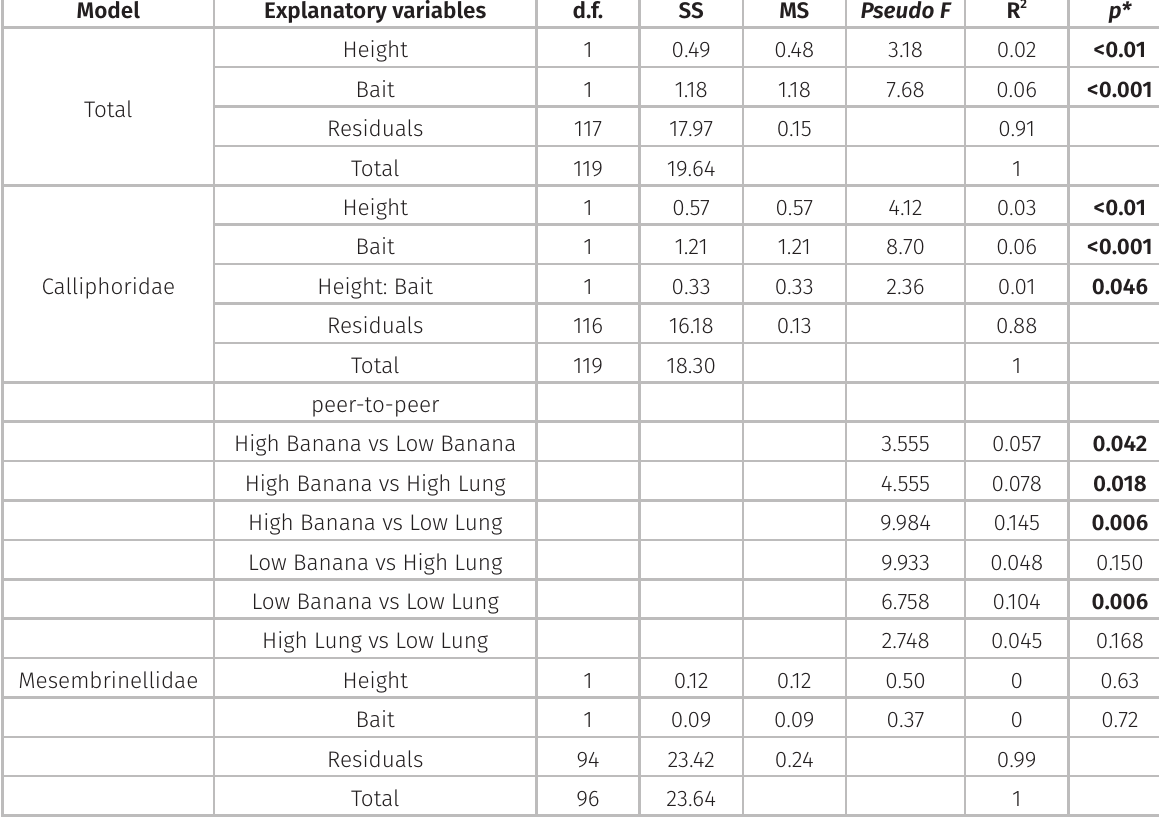
Table III. PERMANOVA result for the response of the Calliphoridae and Mesembrinellidae families fly composition in relation to the heights (high and low) and baits (lung and banana) collected in the Forest in Mazagão municipality, Amapá State, Brazil. Degrees of freedom (d.f.); Sum of squares (SS); Average of squares